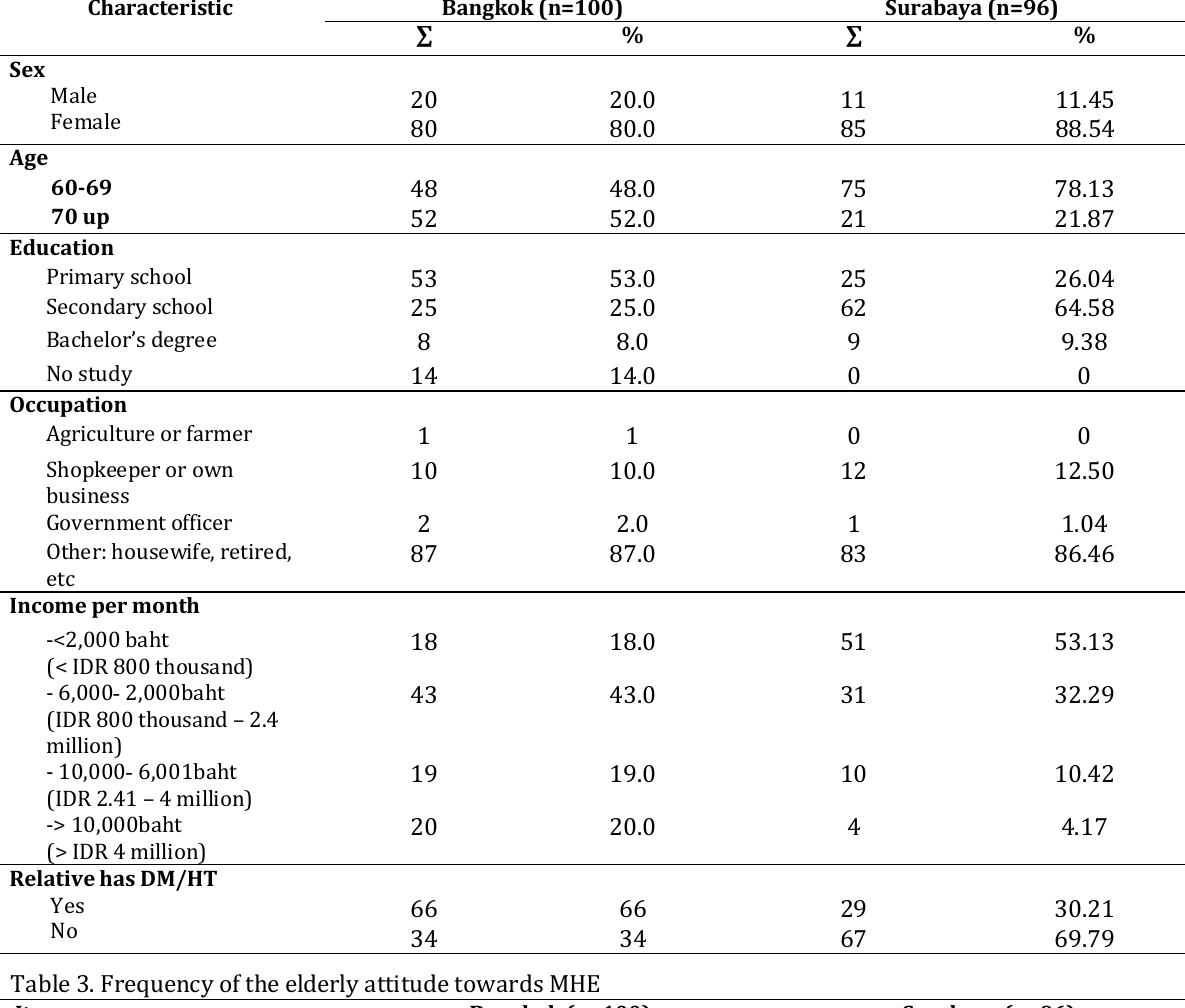
Table 2. Demographic characteristics